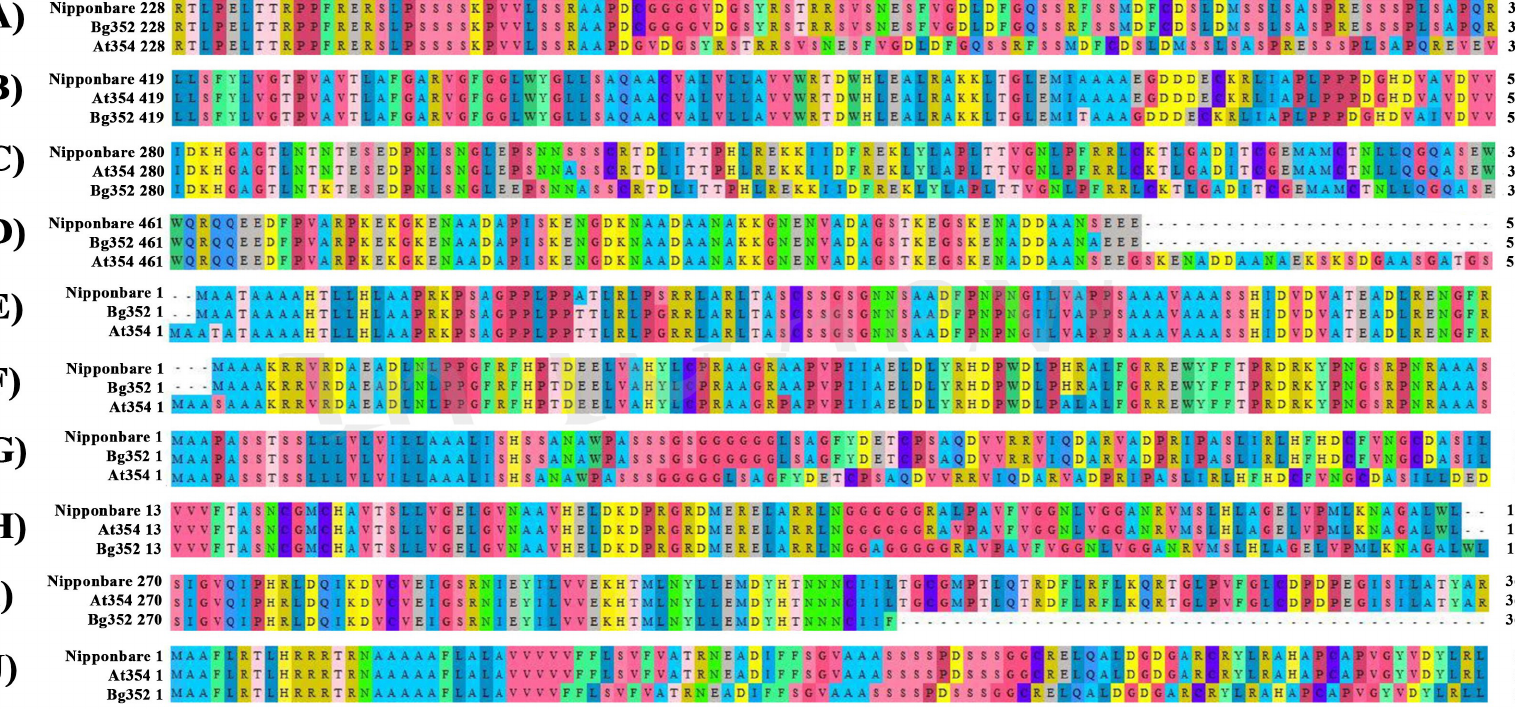
Figure 3. Sequence alignment showing the amino acid sequence coded by putative candidate genes detected with InDel variations. ( a ) Os01g0581400 , ( b ) Os03g0839200